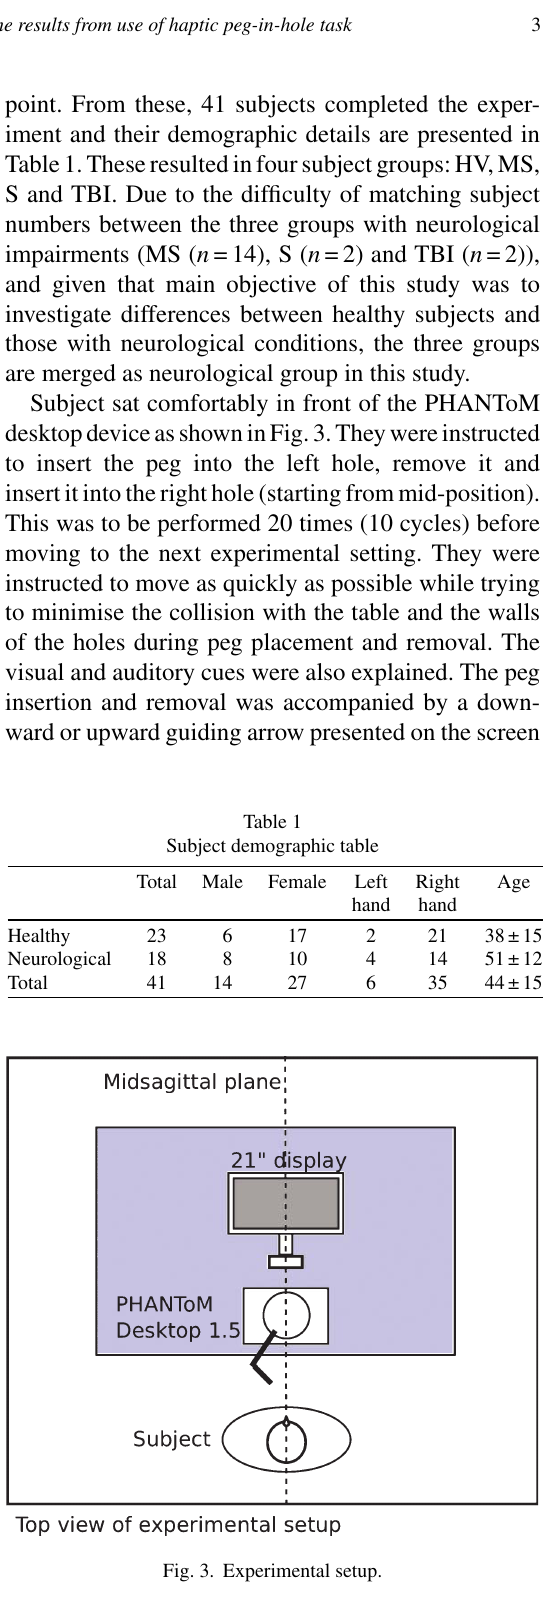
Fig. 3. Experimental